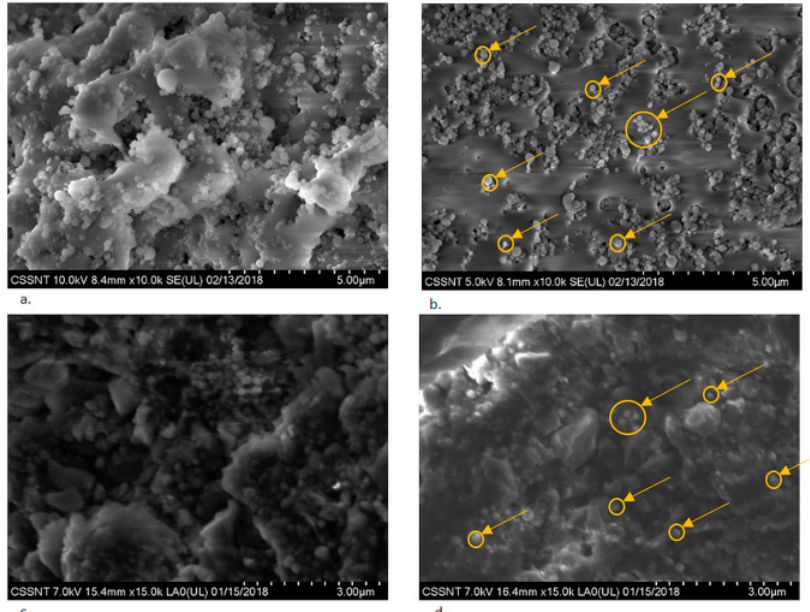
Figure 1. SEM images of ( a ) Dent 100 (not polymerized) and ( b ) newly obtained nanocomposite (not polymerized). Low-angle backscattering electron image of ( c ) 3D-printed E-Dent 100 and ( d ) newly obtained 3D-printed nanocomposite. Titania nanoparticles are marked with yelow circles in subfigures (b) and (d).